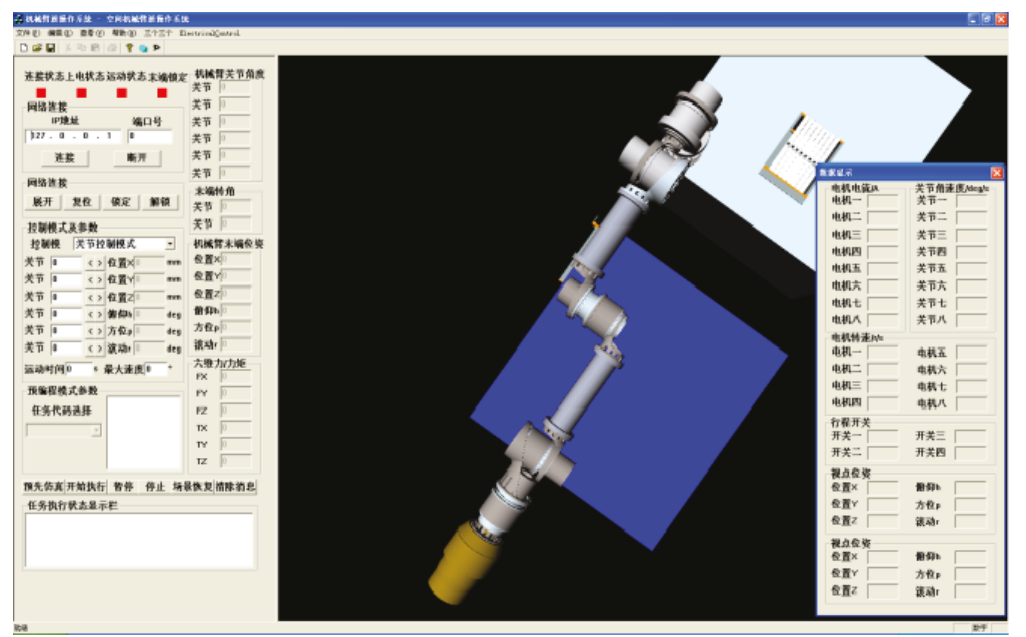
Figure 11: GUI of the tel operation